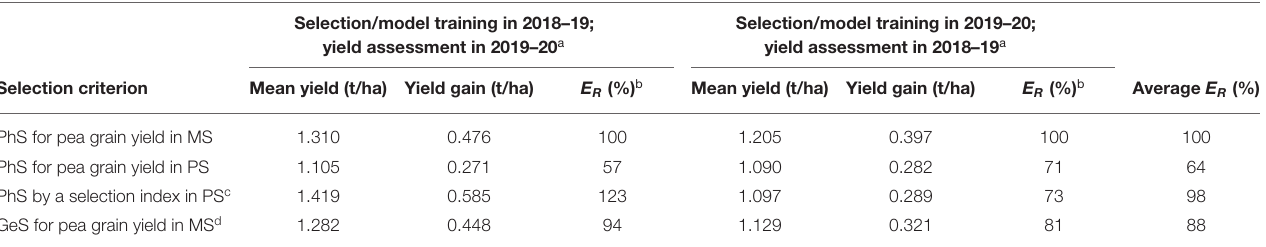
TABLE 7 | Mean grain yield and actual yield gain in mixed stand with cereals (MS) of pea lines selected within each of six recombinant inbred line (RIL) populations according to three phenotypic selection (PhS) criteria based on MS or pure stand (PS) selection and one genomic selection (GeS) criterion by performing PhS or GeS model training in one year and assessing yield gains of selected material in another year, and efficiency ( E R ) of selection criteria relative to PhS selection in MS, based on data of 144 pea inbred lines grown in two cropping years.